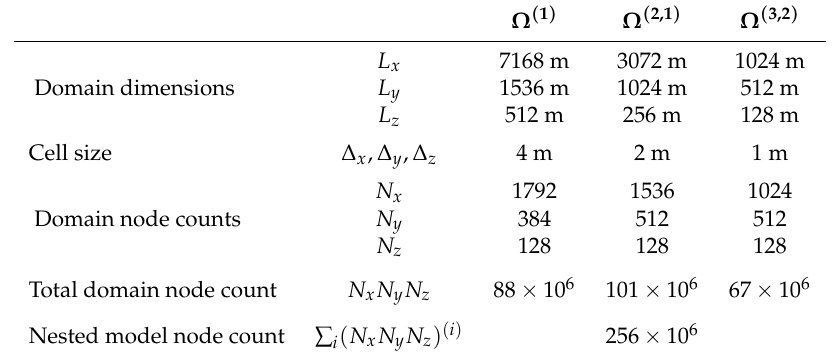
Table 1. Dimensions and grid specifications for the nested Large-Eddy Simulation (LES)